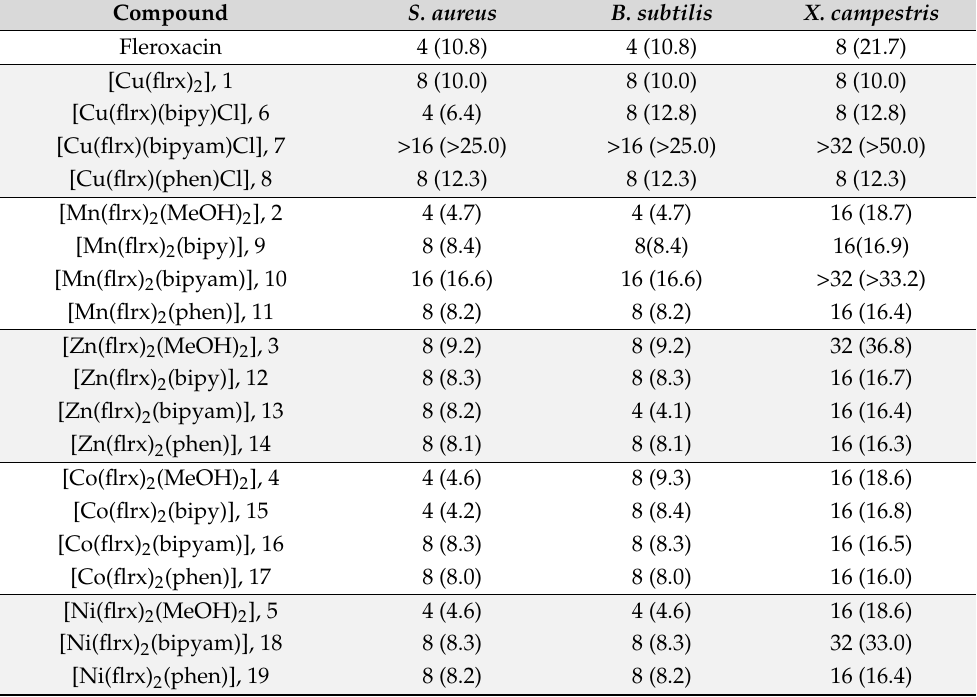
Table 4. Antimicrobial activity of fleroxacin and its complexes 1 – 19 against S. aureus, B. subtilis and X. campestris expressed in MIC (in µ g/mL and µ M (values in parentheses)).